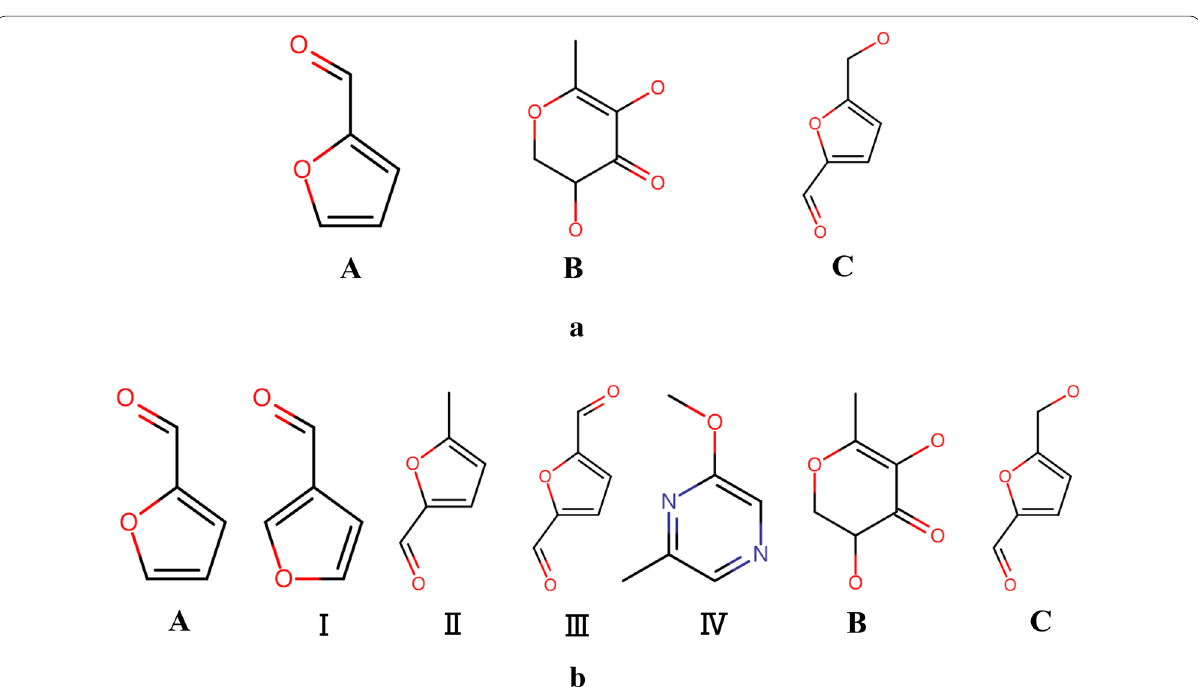
Fig. 7 Chemical structure of the identified compounds in the evolved gas derived from the uncured EH and EHADP adhesive heated at 170 °C for 60